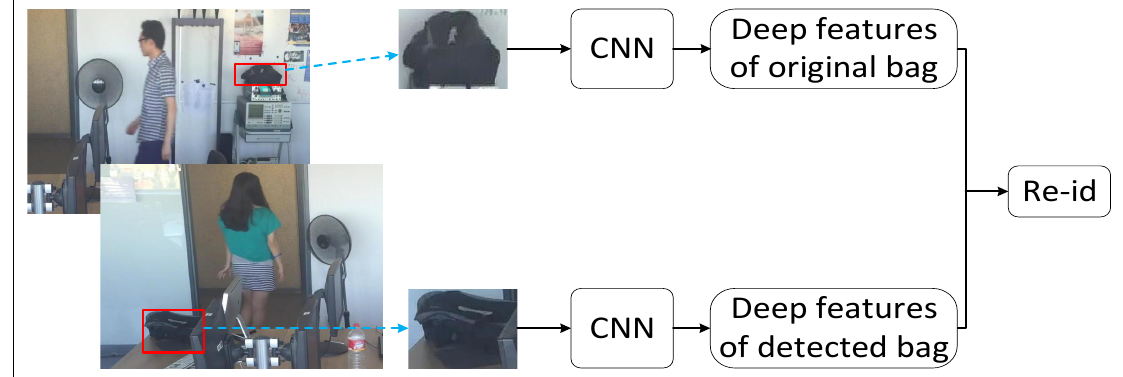
Figure 3: Flowchart for person verification. 20 samples for the owner and the un-owner are extracted from the video sequence respec- tively. Then a CNN model which is specially trained for verification task is used to extract deep representation of each sample. Finally the person re-identification is done by comparing the deep features between the owner and the query person.